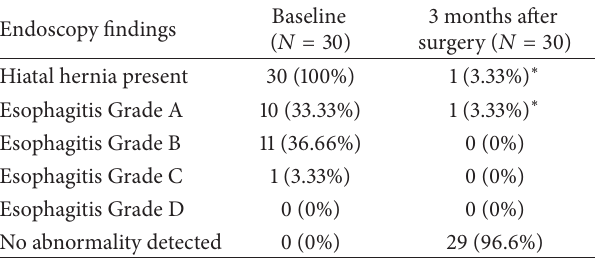
Table 2: Comparison of changes in endoscopy findings in operated